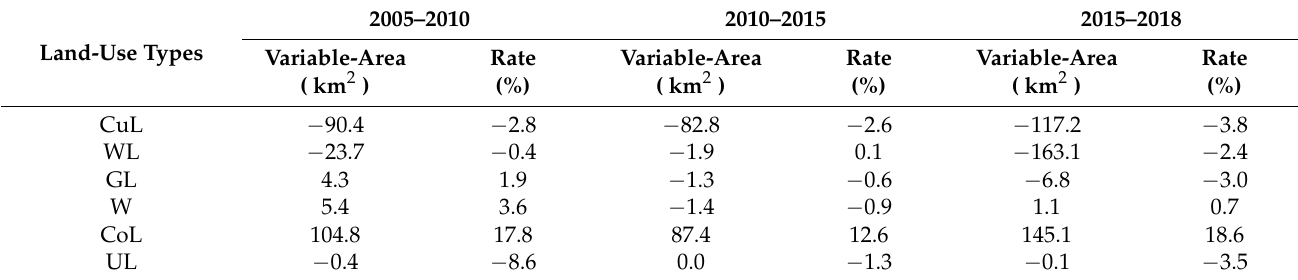
Table 6. Area changes for different land-use types from 2005 to 2018.